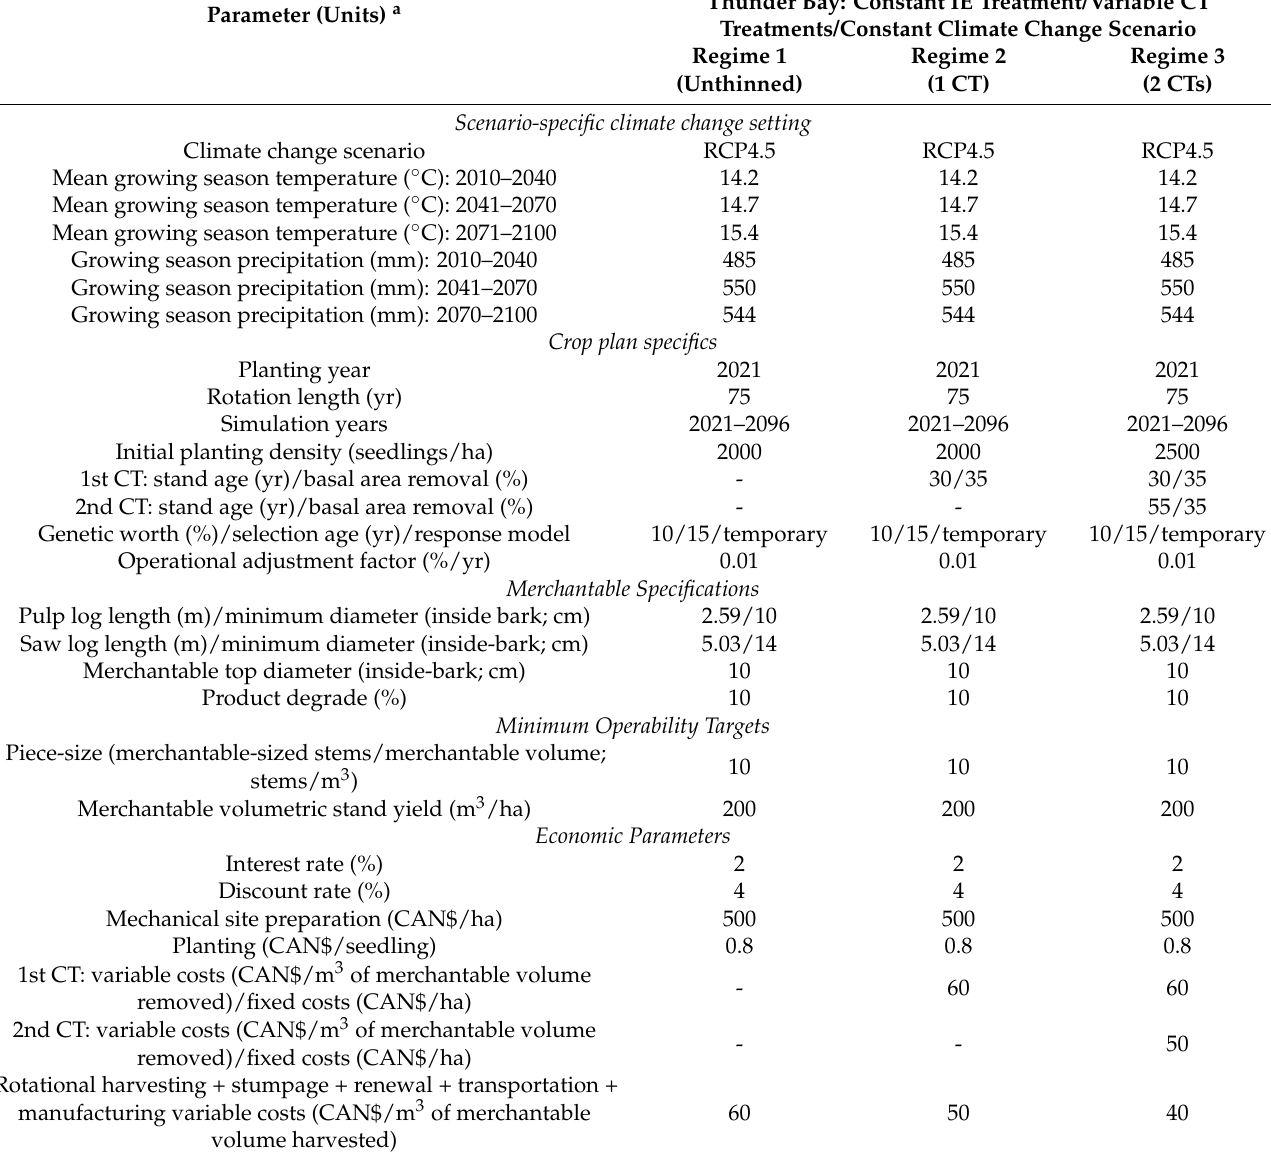
Table 5. Crop planning simulation input parameters for the climate sensitive variant: specific to upland black spruce plantations situated on medium-to-good quality sites in north-central (Thunder Bay) Ontario, established at a common initial espacement (IE) level, with and without subsequent commercial thinning (CT) treatments, and growing under a RCP4.5 climate change scenario over 75 yr rotations